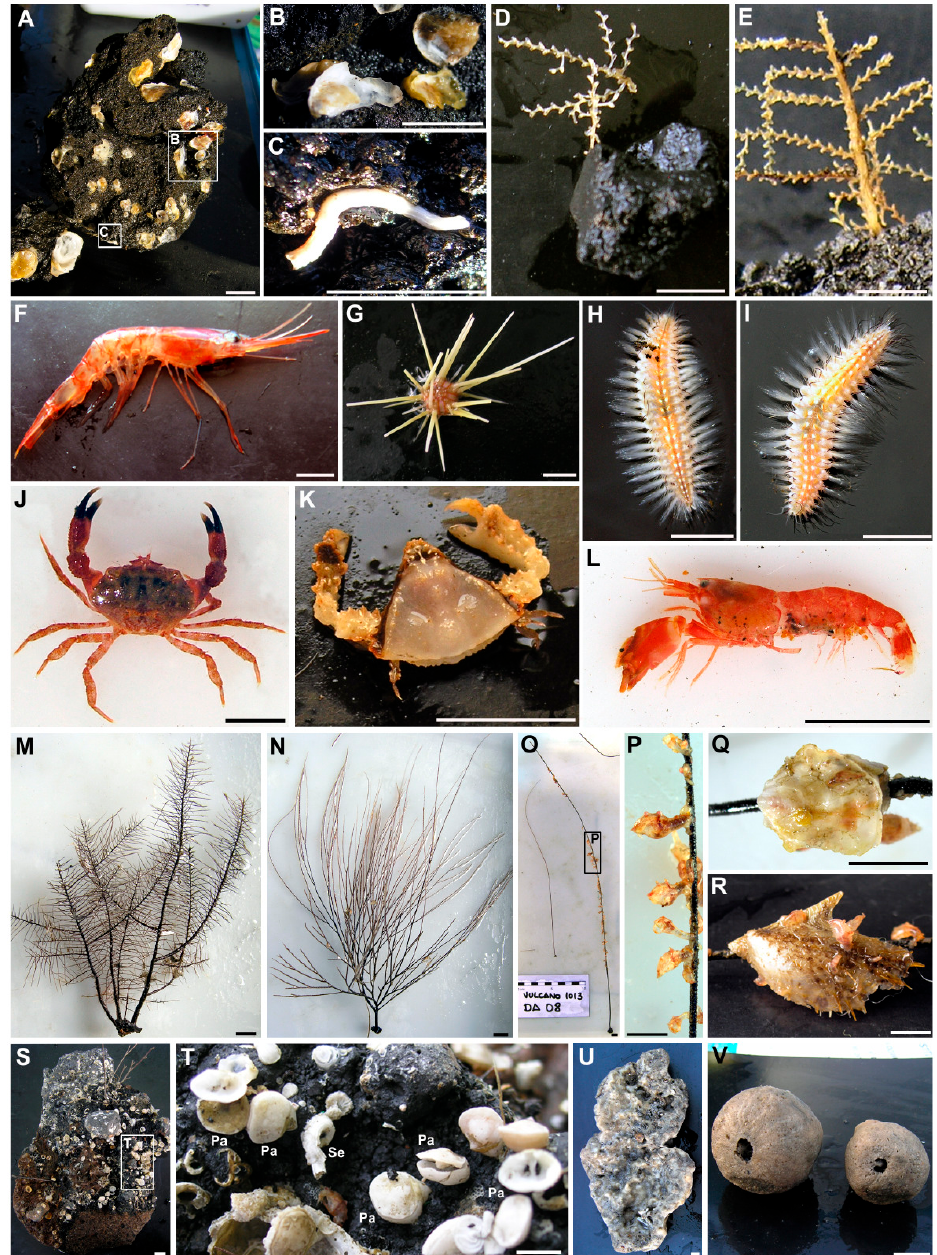
Figure 8. Biodiversity associated with new hard substrate and mixed substrate habitats within the Tagoro volcano complex ( A – L ), and with neighbouring stable hard substrates located at an undisturbed area close to “La Restinga-Mar de las Calmas” Marine Reserve ( M – V ). ( A ) Volcanic rock of new formation with small-size specimens of the ostreid bivalve Neopycnodonte cochlear (detailed in B ) and serpulid worm (detailed in C ). ( D , E ) Small colonies of the hydrozoan Sertularella cf. tenella colonizing newly formed volcanic rocks. Other dominant colonizers include the shrimp Plesionika narval ( F ); small-sized individuals of the echinoid Coelopleurus floridanus ( G ); the annelid Chloeia cf. venusta ( H , I ); small decapods such as Monodaeus couchii ( J ); Velolambrus cf. expansus ( K ); and Alpheus sp. ( L ). Vulnerable habitat-forming species were mainly represented by antipatharians, such as Tanacetipathes cf. cavernicola ( M ); Antipathes furcata ( N ); and Stichopathes cf. setacea ( O ), the latter being frequently colonized by different epibionts including the cirriped Heteralepas cornuta ( P ); the bivalves N. cochlear ( Q ); and Pteria hirundo (also colonized by small H. cornuta ; R ). Volcanic rocks from past eruptions were also colonized by small epibionts, dominating the brachiopod Pajaudina atlantica (Pa) and different serpulid species (Se; S , T ), as well as large non-identified desmosponges ( U , V ). Scale bars represent 1